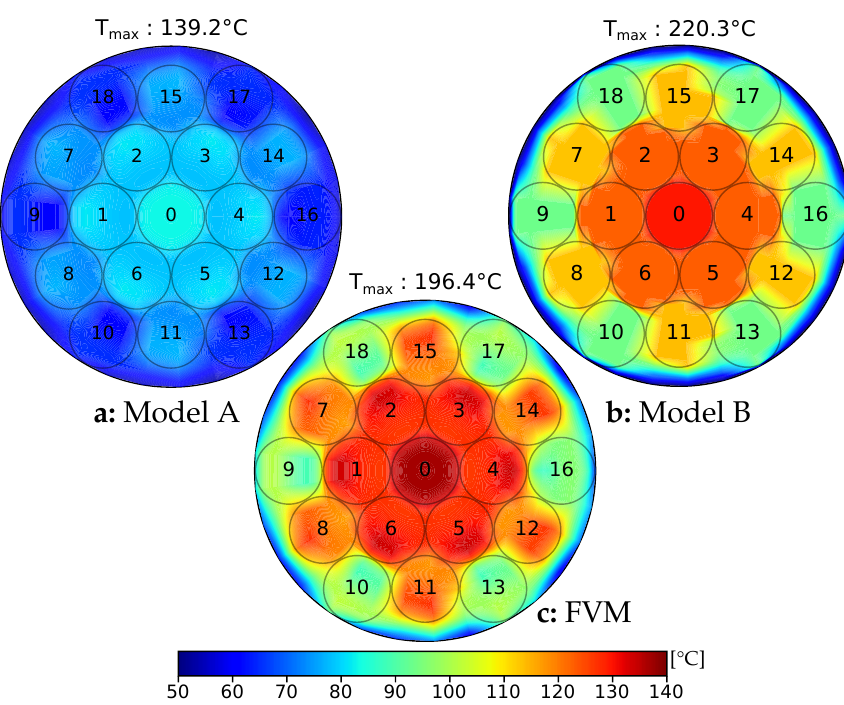
Figure A3. Comparison of thermal contours for round shape with a hexagonal layout between method A ( a ), method B ( b ) and FVM ( c ). Results data from Table 2.